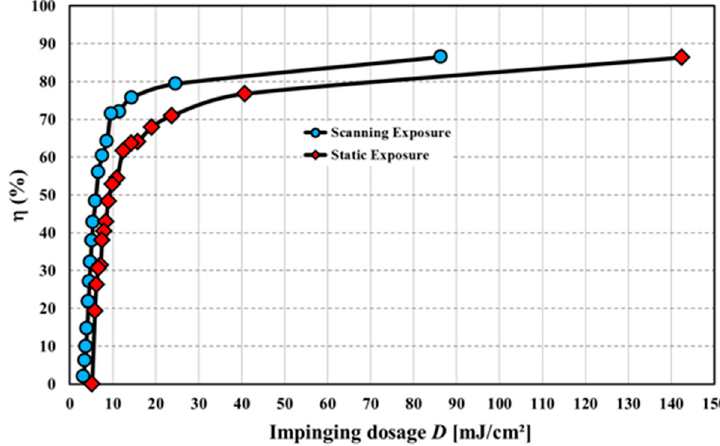
Figure 28. Evidence of independence on vibrations in the contact copy process: using the scanning exposure ( circles ) a similar dosage response curve as in the static exposure ( diamonds ) is achieved for various scanning speeds. Thus, vibrations do not deteriorate the diffraction efficiency η as in the copy with spacing case [55].